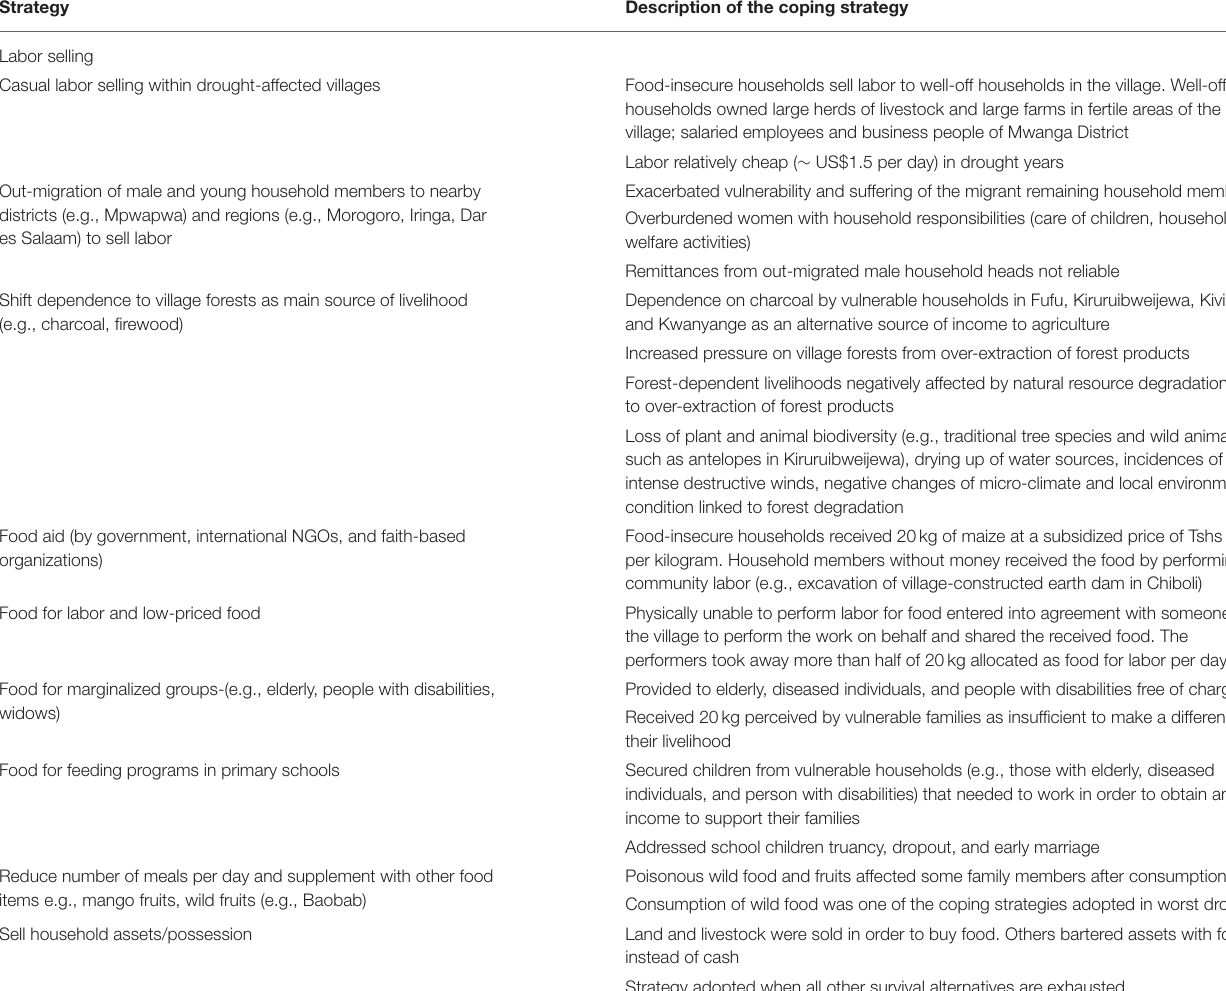
TABLE 8 | Coping strategies by the vulnerable households to food insecurity.